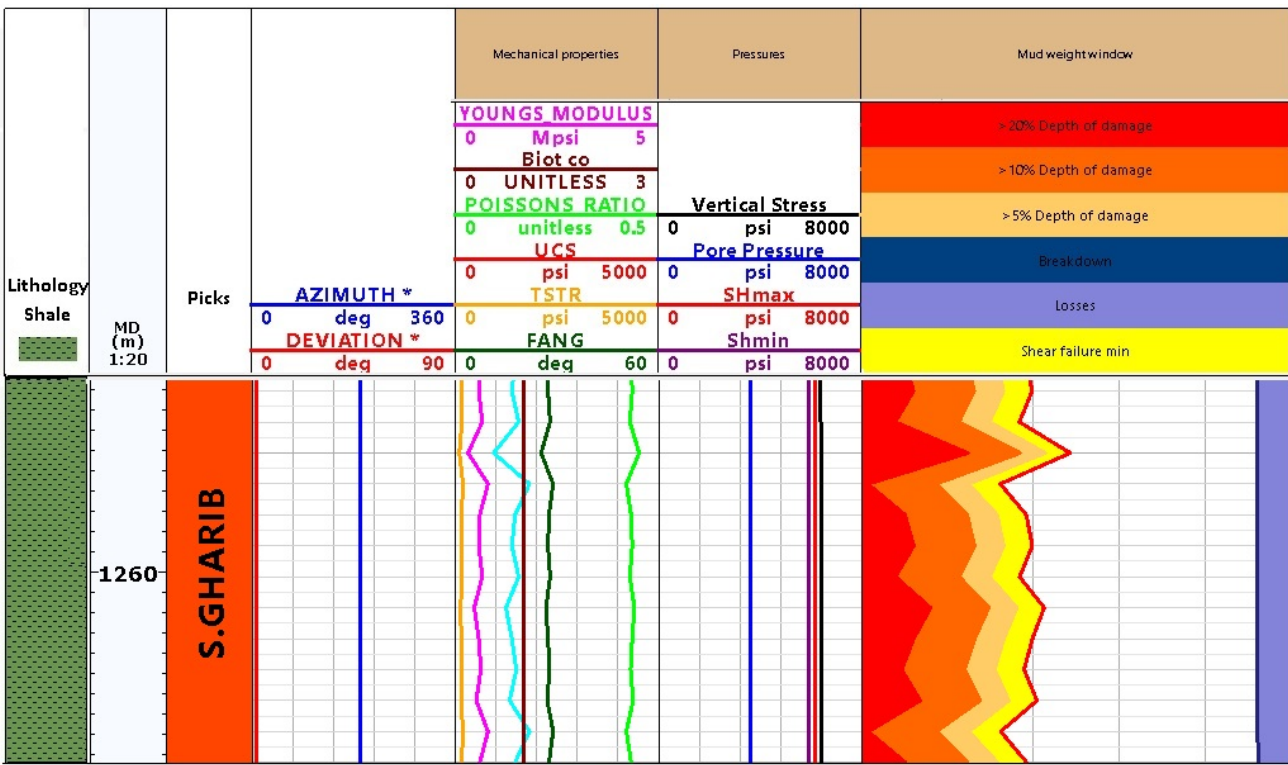
Figure 9. WBS model of South Gharib Formation in El Morgan-A1 well. Track 1 (Lithology), Track 2 (Depth), Track 3 (Picks), Track 4 (Hole deviation and Azimuth), Track 5 (mechanical properties), Track 6 (Vertical stress, Shmin, SHmax, and pore pressure), Track 7 (mud weight window). For the different colors in track 7, readers should refer to Figure 4 in this article.